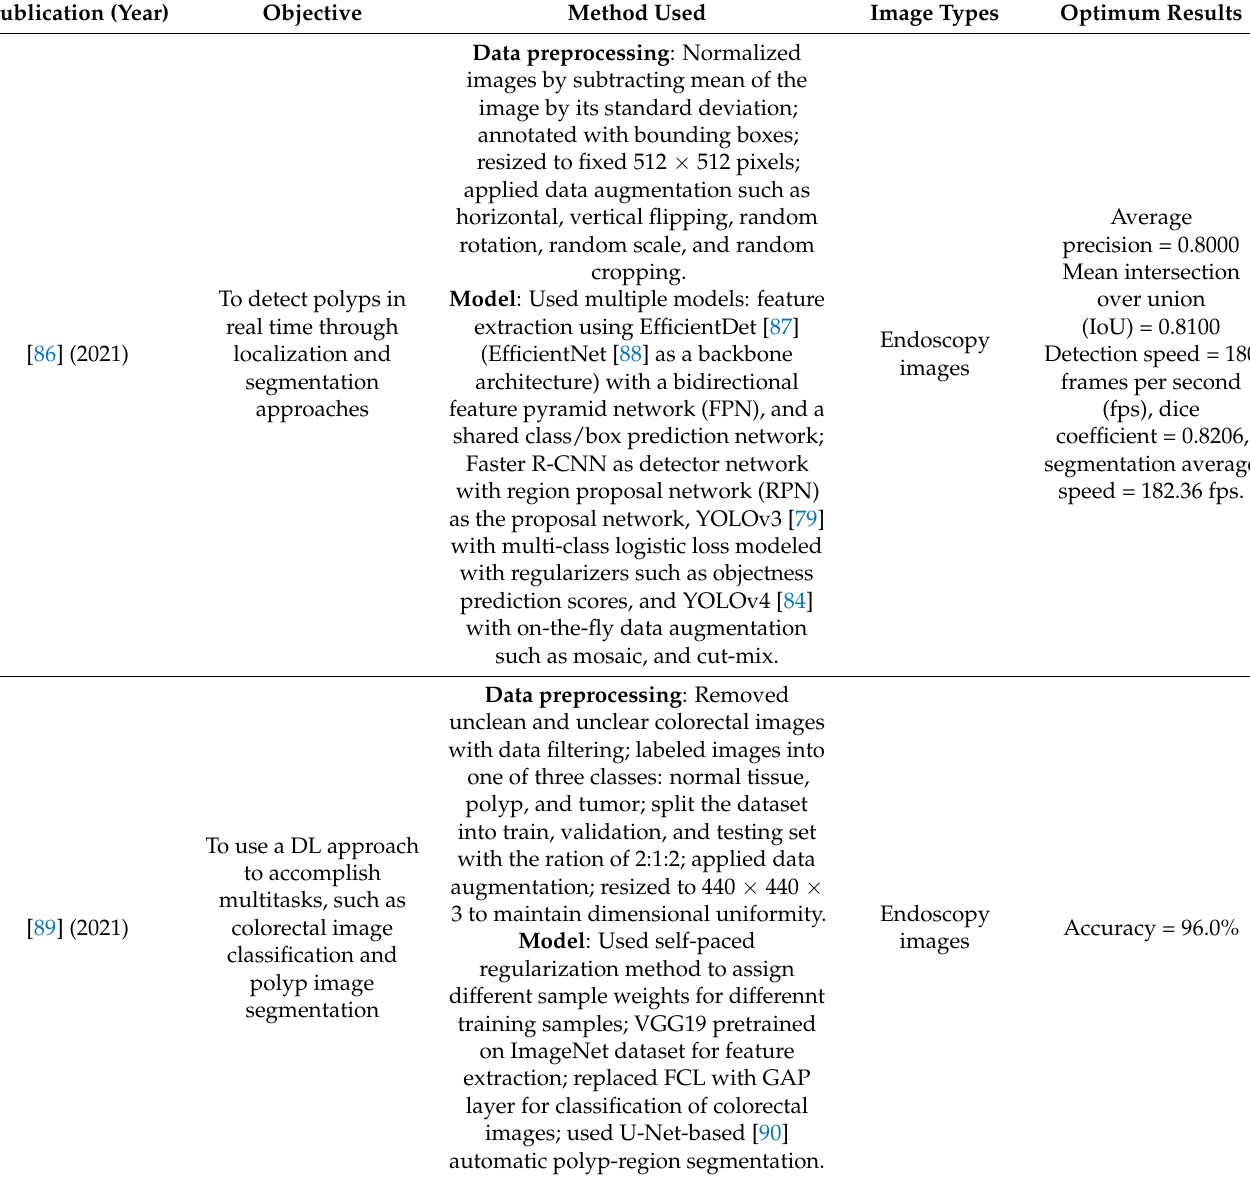
Table 5. Some recently published articles on polyp detection in CRC by using DL